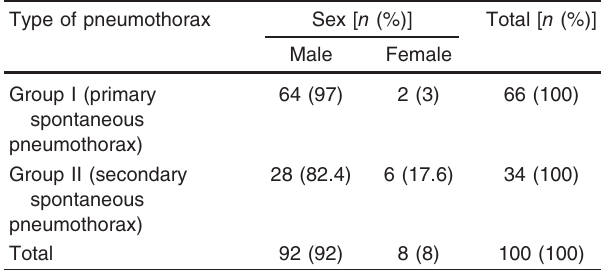
Table 1 Types of pneumothorax and sex of the studied patients Type of